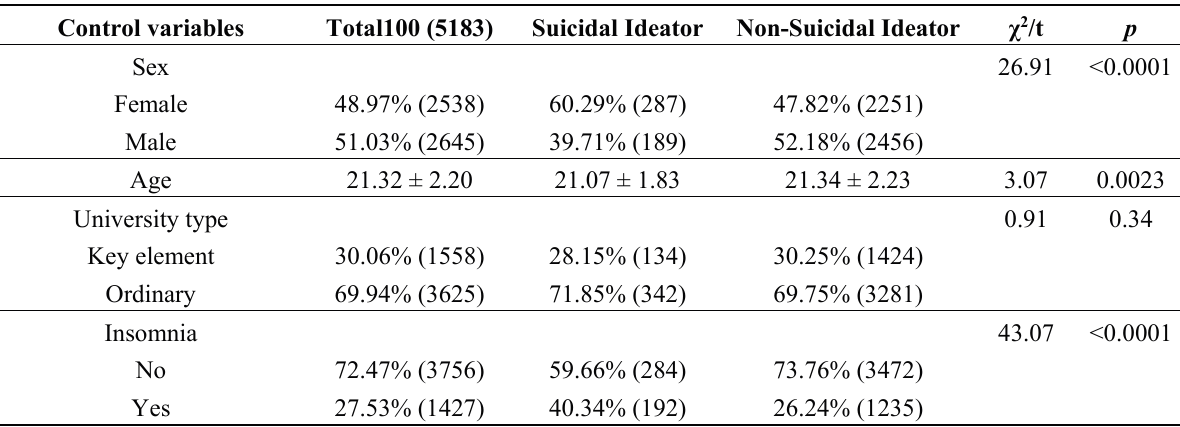
Table 1. Distribution and family controlled variables of the Chinese university student sample according to suicidal